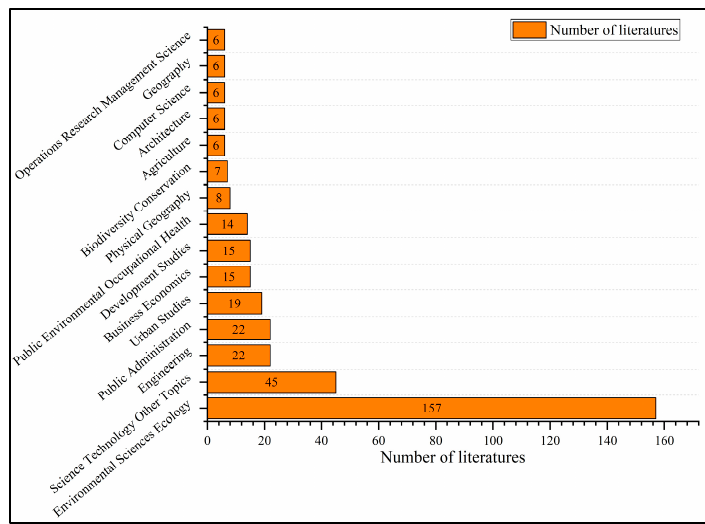
Figure 4. Research direction and the number of papers in the literature.